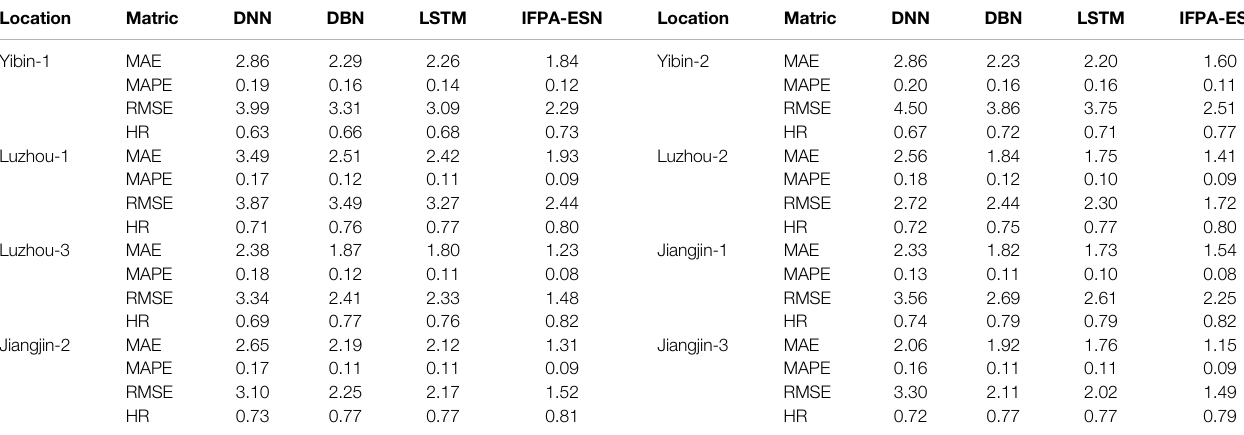
TABLE 5 | Nitrate concentration prediction with conventional time-series modeling. Location